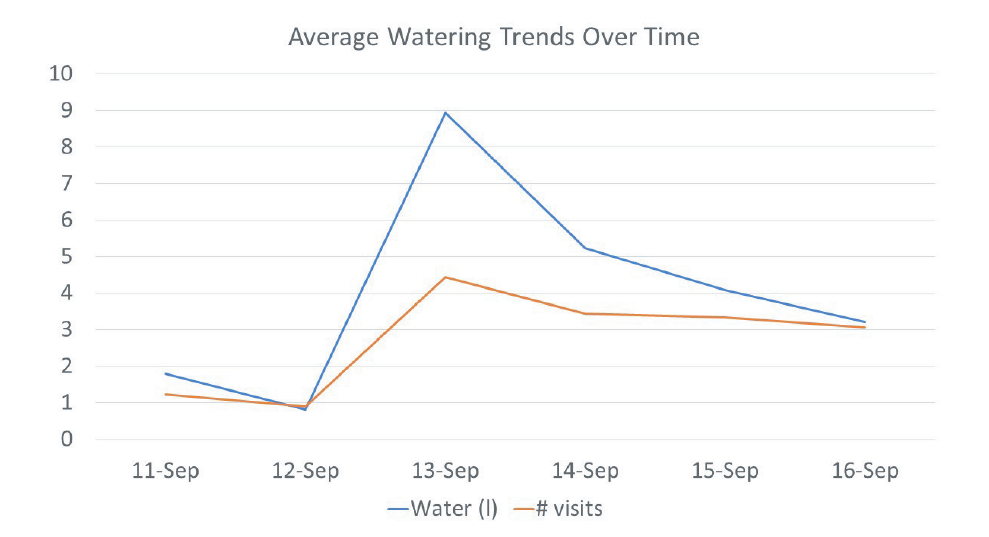
Figure 15. Daily average watering behavior of the drinking station in terms the number of visits and water intake